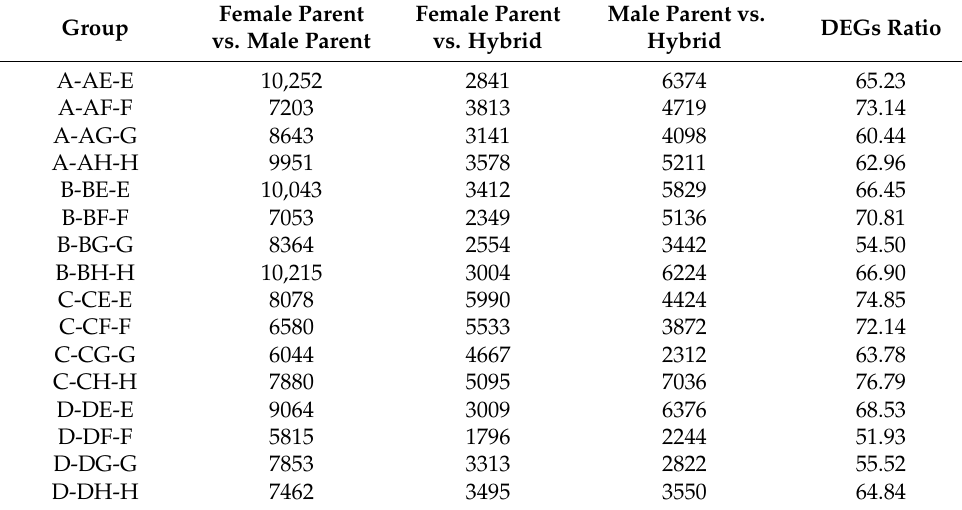
DEGs Ratio: the ratio of DEGs (there were differential expression in two comparison groups (female parent vs. hybrid or male parent vs. hybrid)) to DEGs (there were differential expression in a comparison group (female parent-vs-male